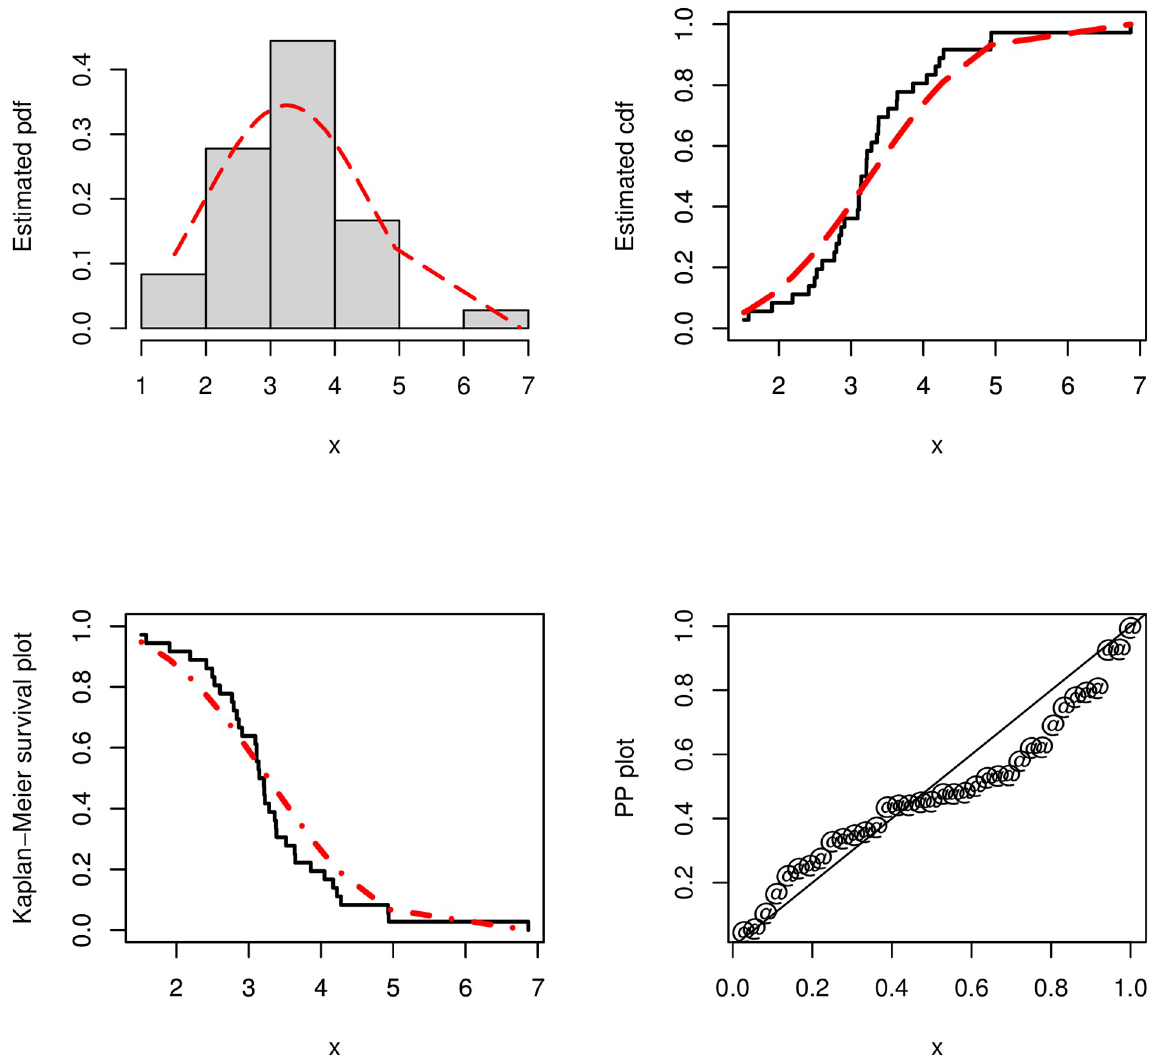
Fig 18. The estimated pdf, cdf, PP and Kaplan-Meier survival plots of the ASM-Weibull distribution for the second COVID-19